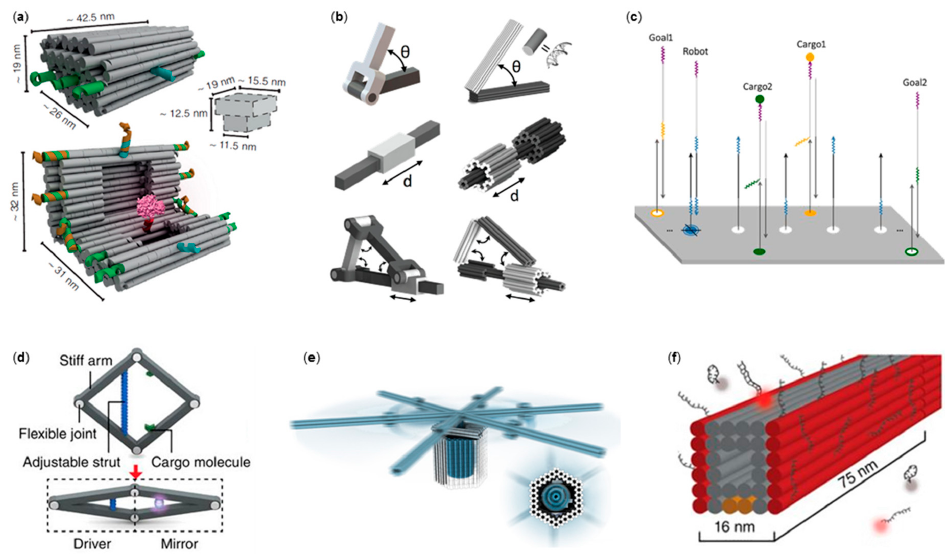
Figure 1. DNA origami mechanics via DNA–DNA interaction. ( a ) A DNA nanovault that displays cargo when opened via strand displacement [61]; ( b ) DNA origami nanomechanics [67]; ( c ) A